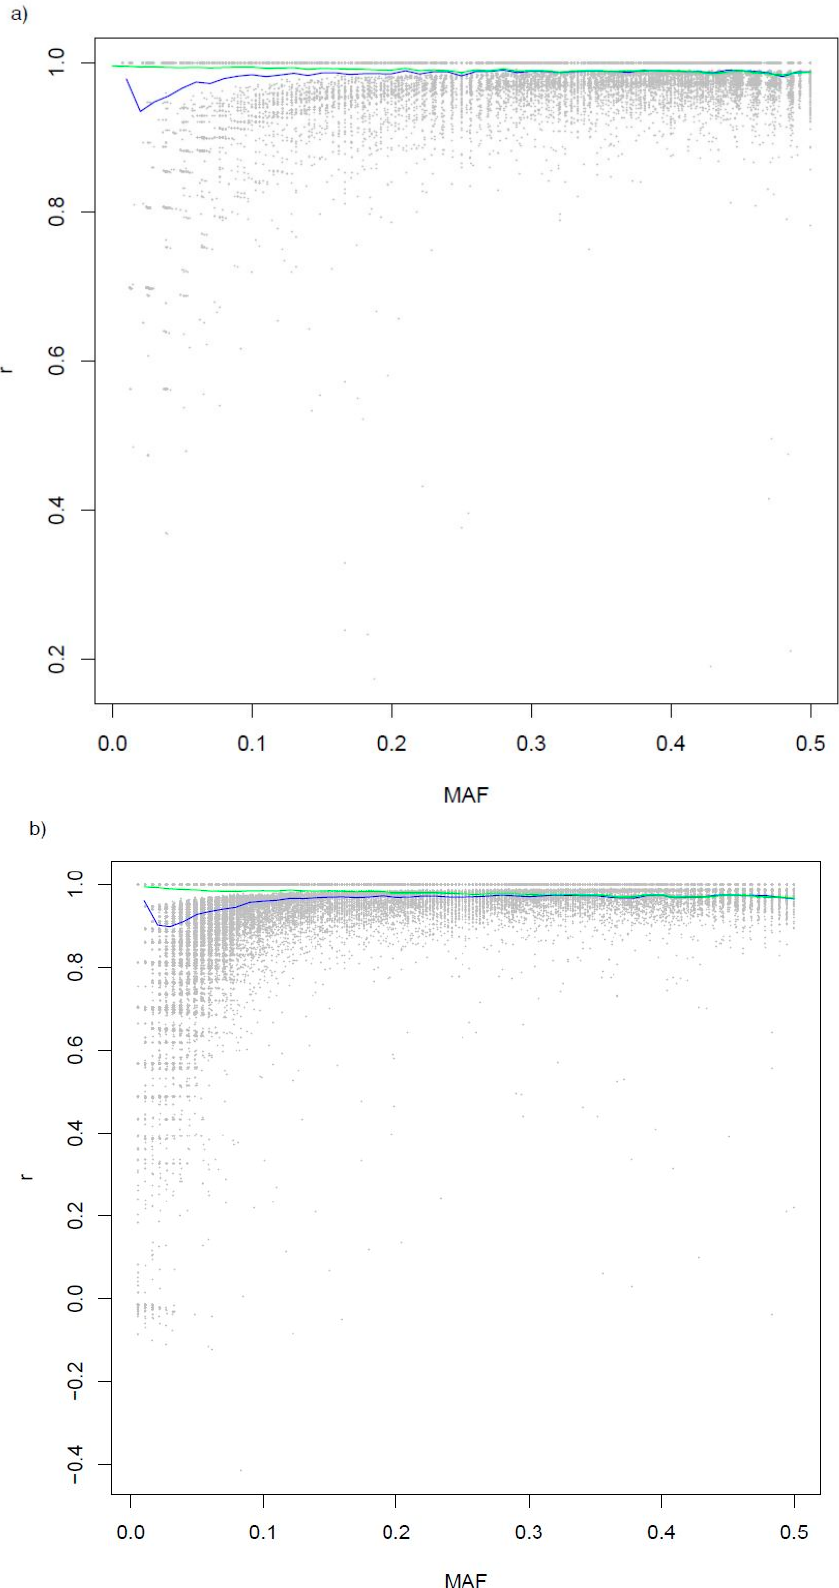
Figure 3. Relationship between imputation accuracy, expressed as a correlation (r) between genotypes imputed from sequence and called from SNP arrays ( a ) or transcript sequence ( b ), and minor allele frequency (MAF). Mean correlation between imputed and called genotypes within 0.01 MAF increments is shown by blue lines, and the green lines show mean concordance within the 0.01 MAF increments.